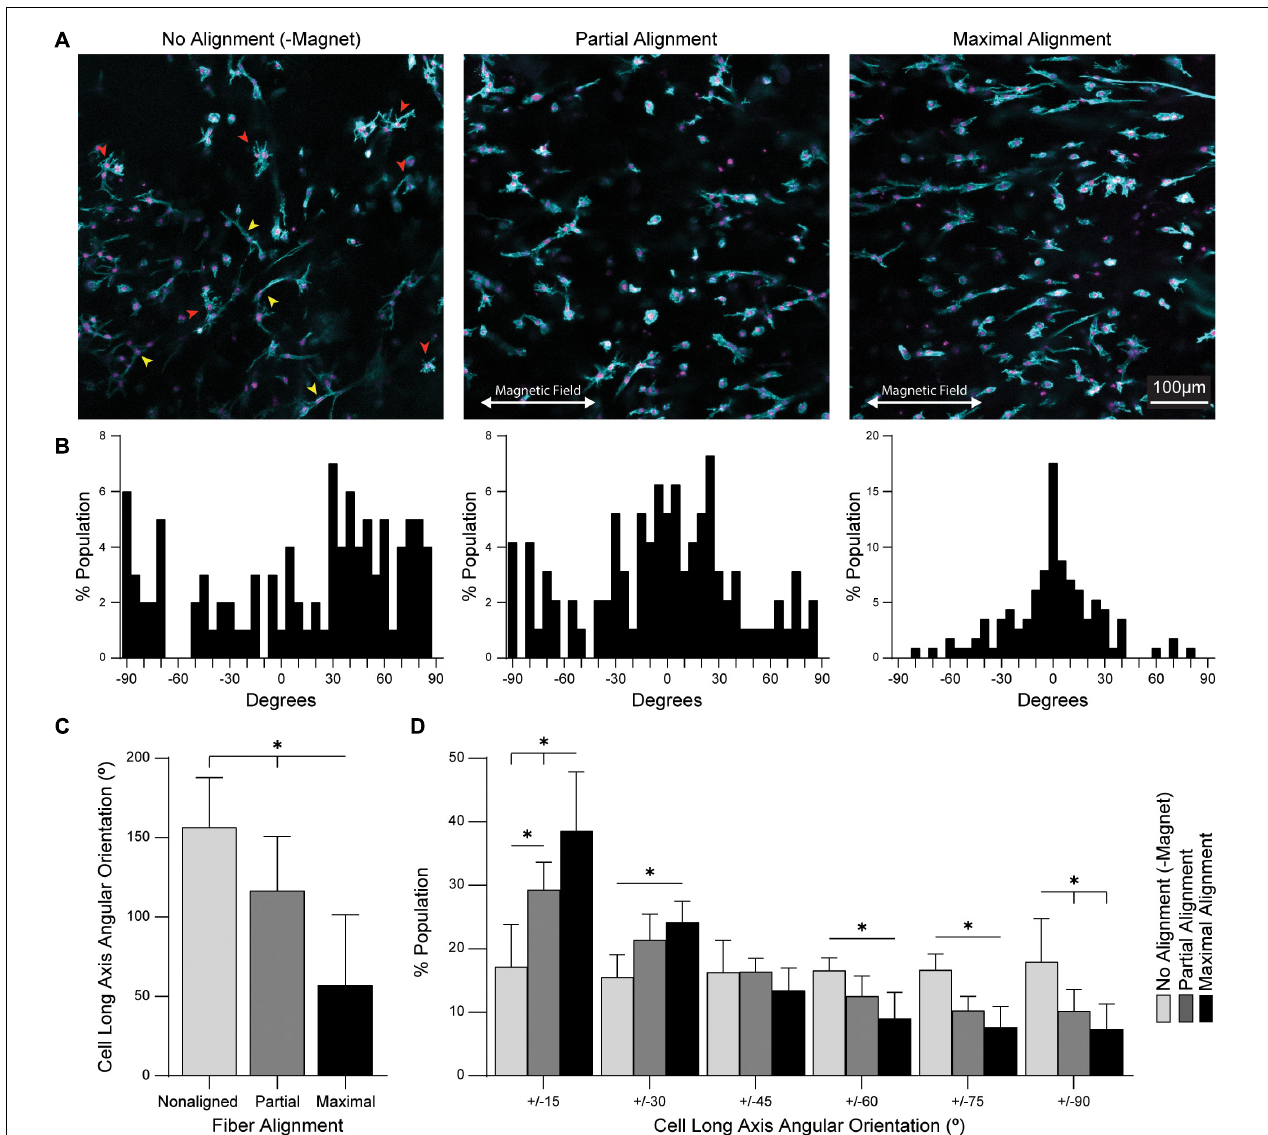
FIGURE 6 | Fiber alignment directs the orientation and morphology of encapsulated tendon fibroblasts. (A) Fluorescent images of primary mouse tendon fibroblasts (tenocytes) cultured in hydrogel composites for 7 days. Red arrowheads indicate stellate morphology cells; yellow arrowheads indicate uniaxially spread cells. (B) Histograms of cell orientation as a function of fiber alignment. (C) Full width-half max quantification of n = 10 cell orientation distributions. (D) Angular stratification of cell orientations as a function of fiber alignment. All data presented as mean ± SD; ∗ indicates a statistically significant comparison with p <